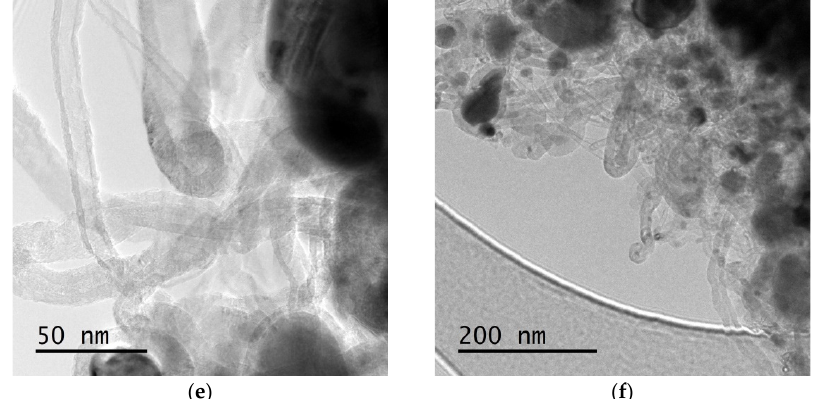
Figure 2. SEM images of MWCNTs after functionalization at various durations: ( a ) 2 min, ( b ) 5 min, and ( c ) 7 min. ( d – f ) TEM images of MWCNTs synthesized (non-treated sample).